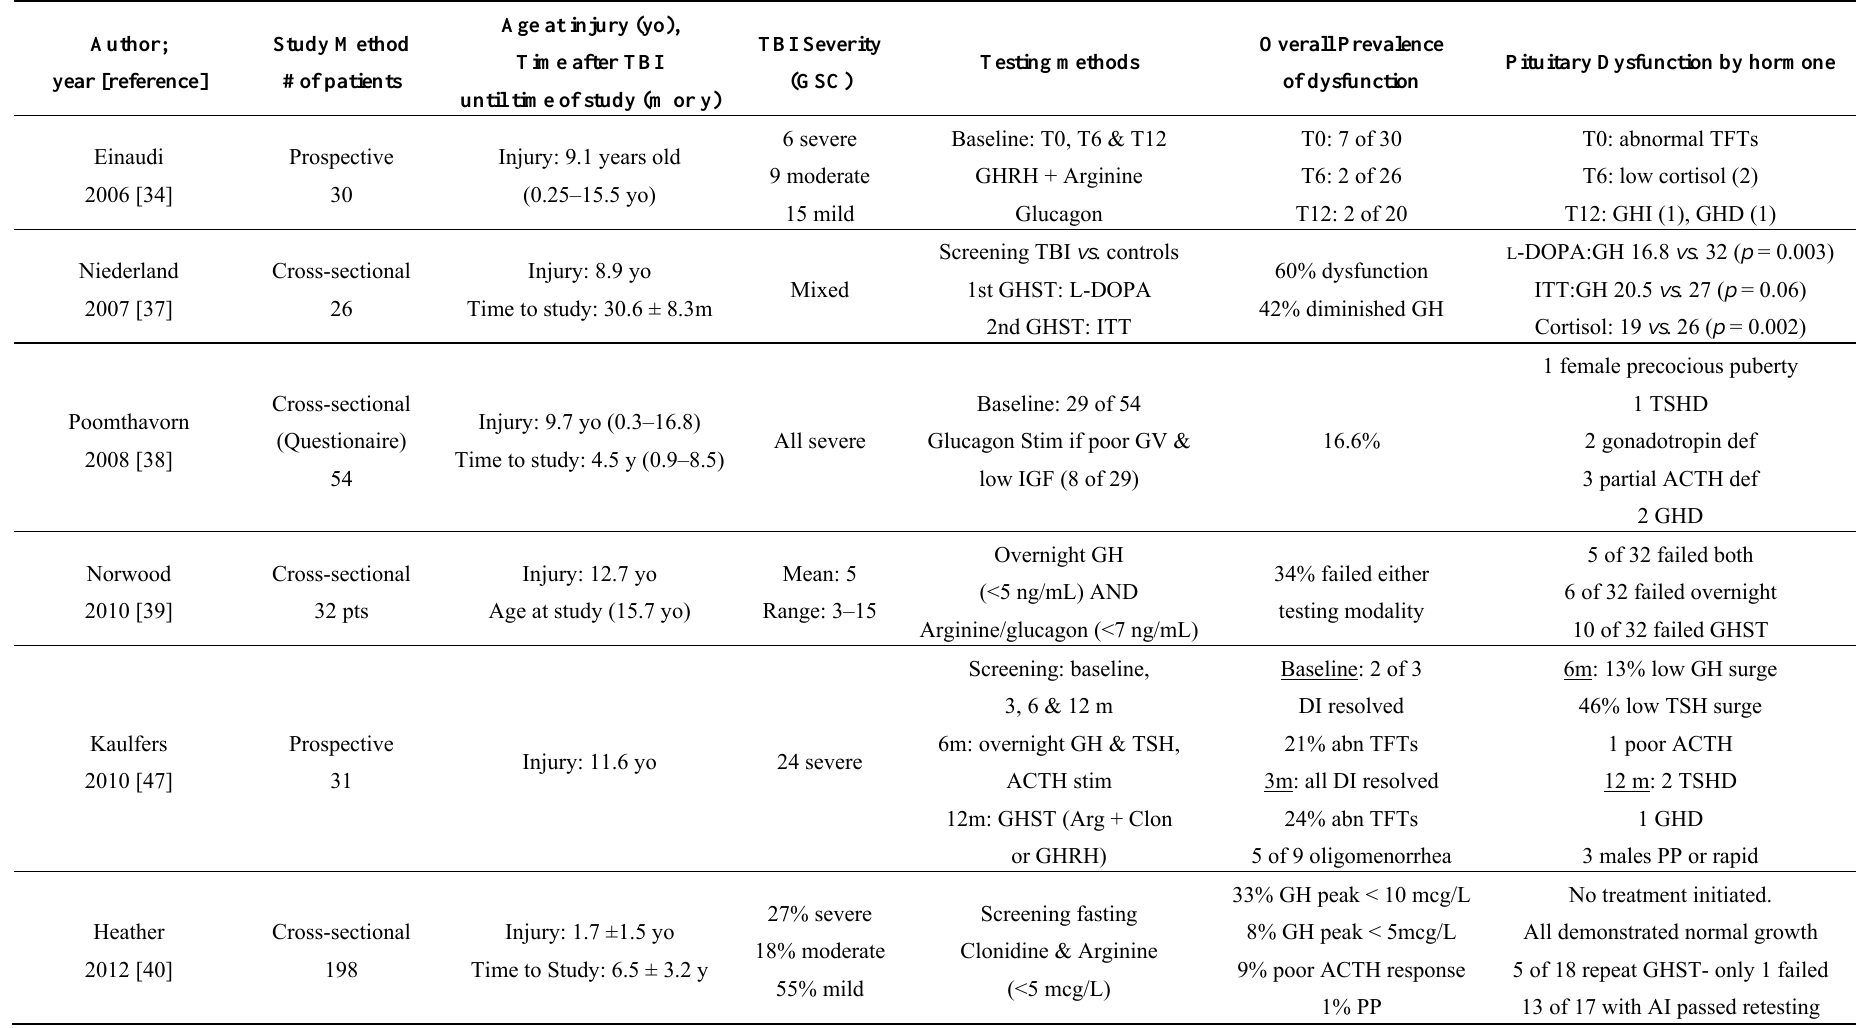
Table 1. Pediatric literature review: Studies of endocrine function after pediatric traumatic brain